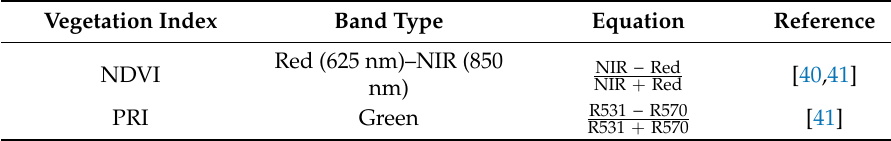
normalized di ff erence vegetation index; and PRI: photochemical reflectance